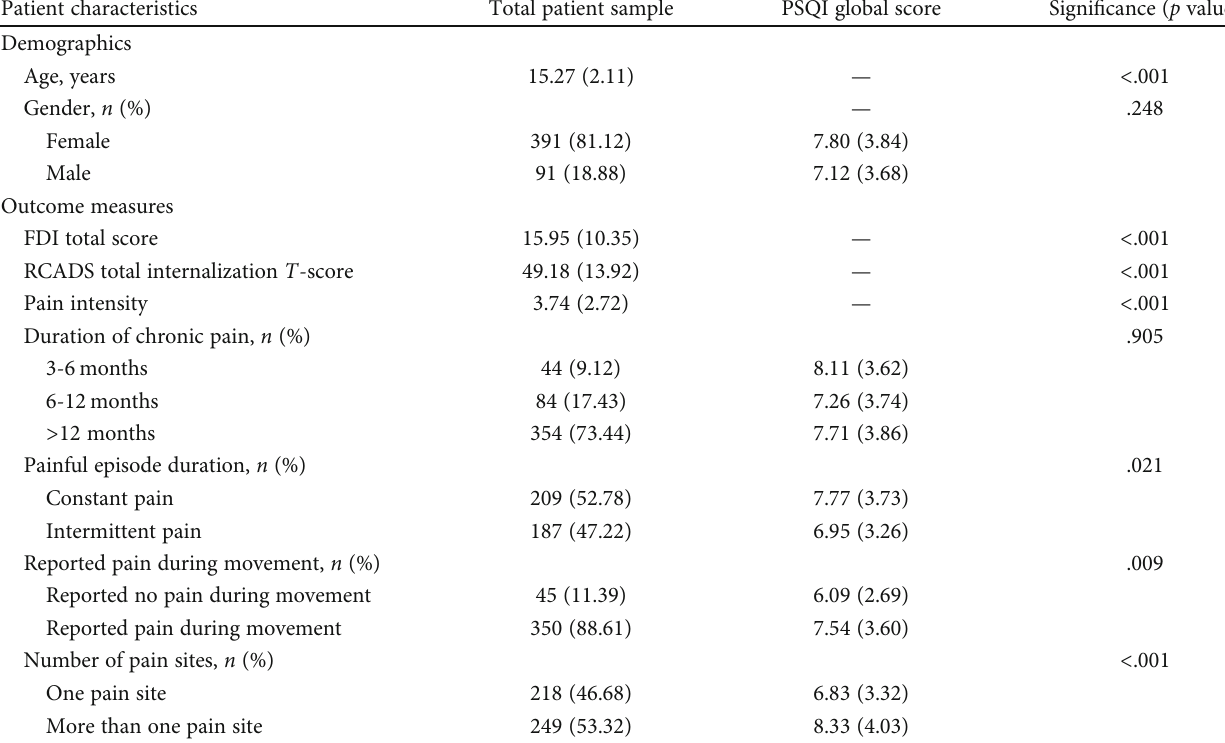
Table 4: Descriptive statistics of patient